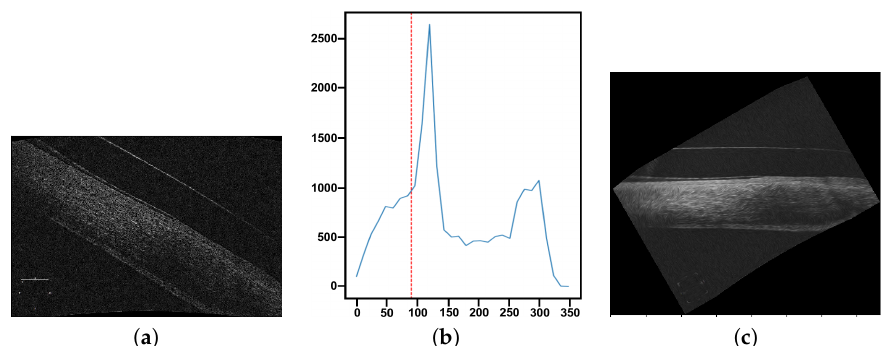
Figure 5. Example of the filtering and rotation process of the preprocessing stage. ( a ) AS-OCT image of a lateral region to be preprocessed. ( b ) Representation of the calculated histogram of oriented gradients (HOGs) where the discontinuous red line marks the majority position that we characterize as horizontal. ( c ) Result of applying the non-linear anisotropic diffusion filter, rotation and the top hat filtering to the image in order to produce an enhanced image with the maximum number of edges with a horizontal distribution.